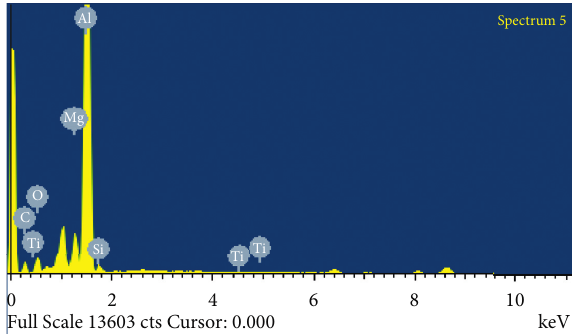
Figure 6: EDAX graph of Al7075 85% and TiB